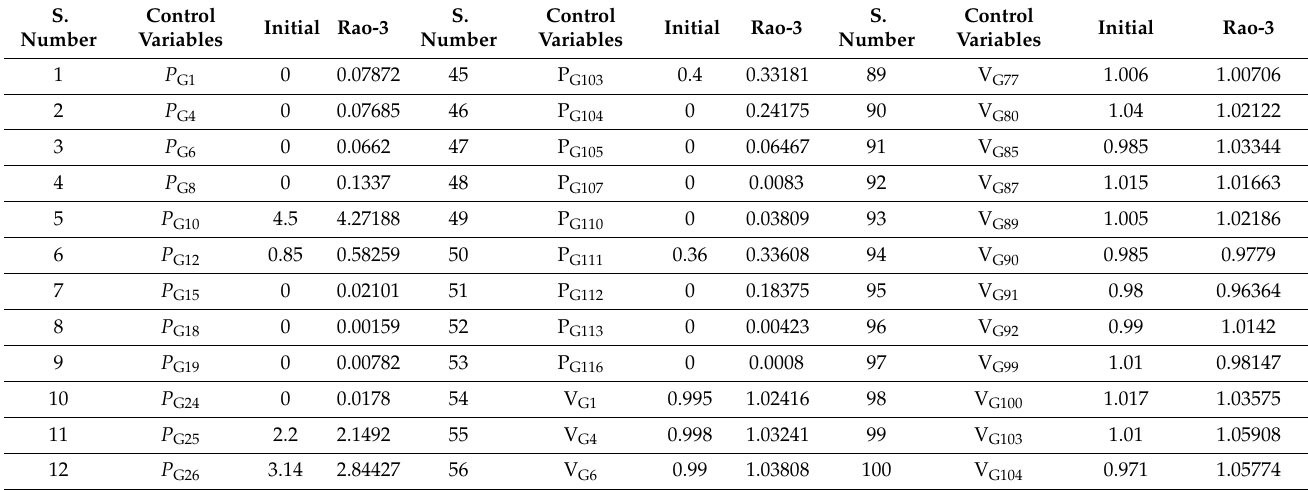
Table 17. Optimum values of control variables of Case 11 for the IEEE 118-bus test system. S.